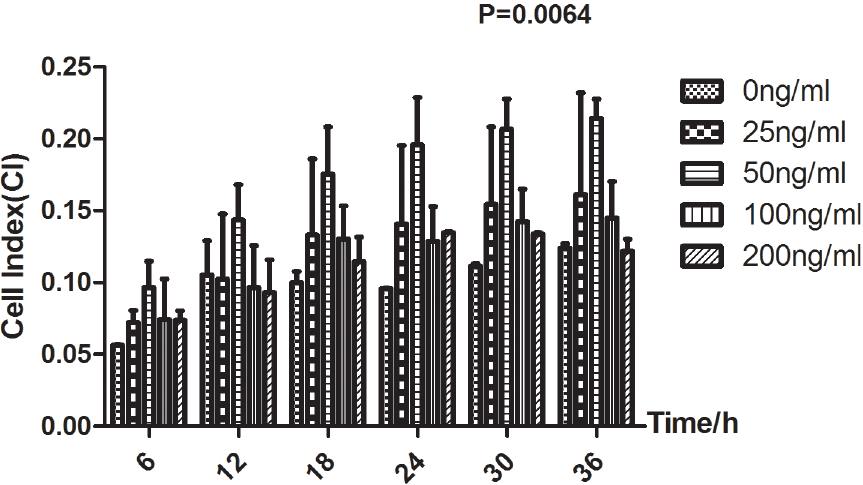
Fig 4. hFOB growth in vitro recorded at multiple time points under various Anxa2 protein concentrations (0- 200ng/ml). Presented are cell indexes (CI) monitored for 36 hours in cell growth assay. The data is described as mean ± SD. It reflected the inverse U-shaped effect of Anxa2 protein on hFOB growth at each representative time point (P = 0.0064).